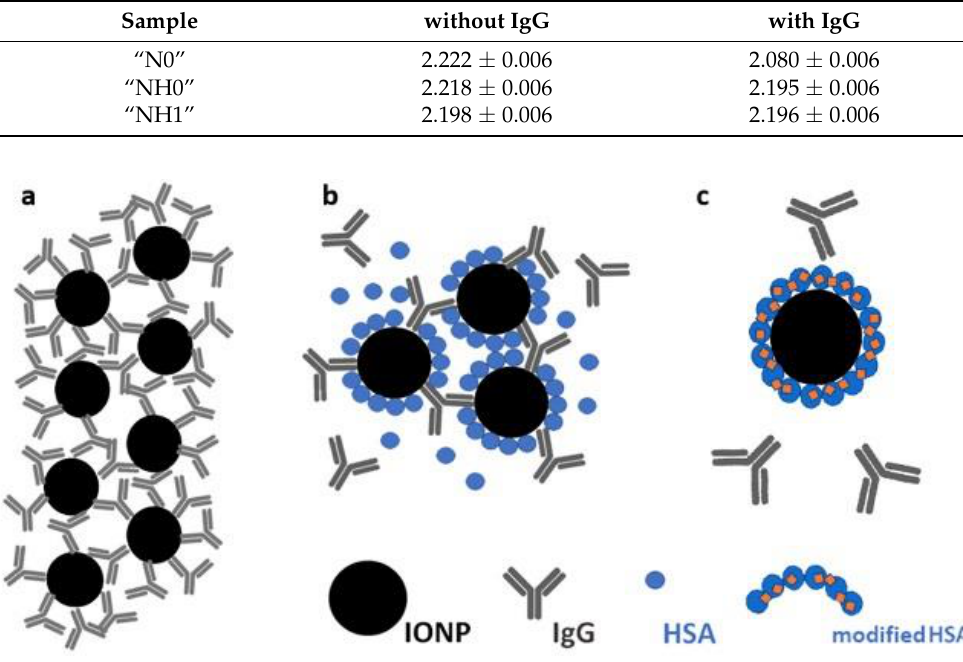
Figure 4. Schematic presentation of the interaction between IONPs and protein in the samples of “N0” ( a ), “NH0” ( b ), and “NH1” ( c ) after the addition of IgG to the solutions.